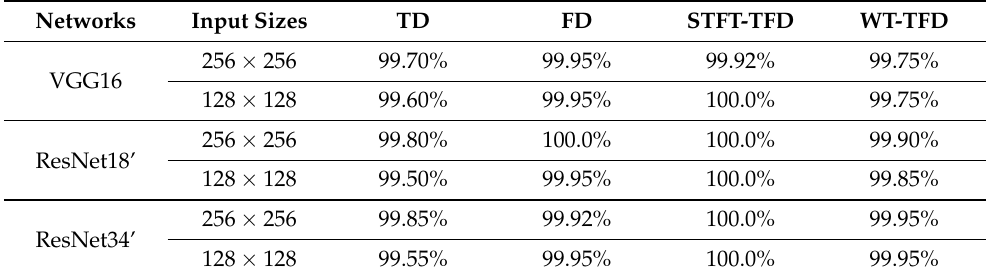
Table 4. Test accuracies of CWRU.